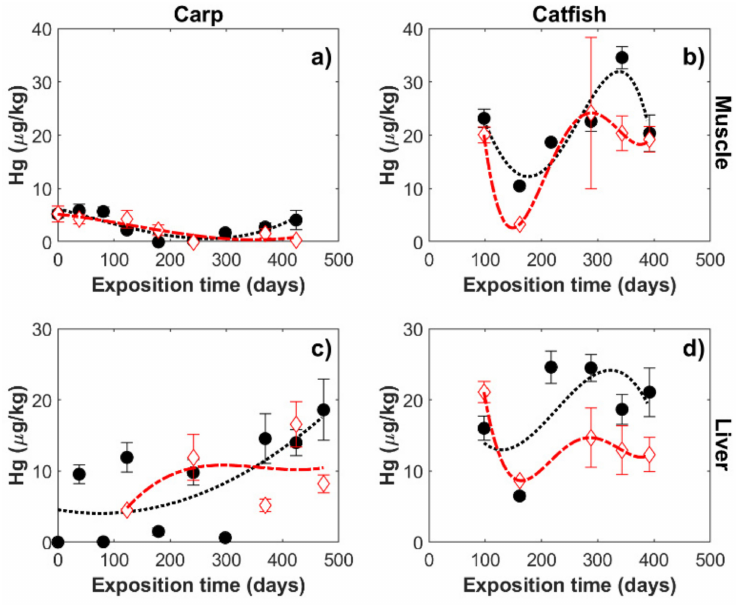
Figure 7. Hg accumulation in the experimental ( • ) and control groups ( carp, ( b ) muscle in catfish, ( c ) liver in carp, and ( d ) liver in